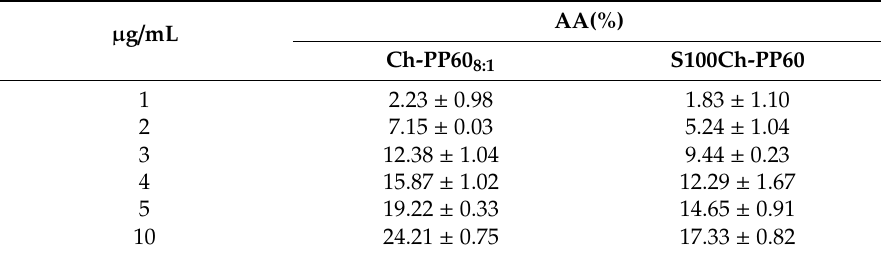
Table 3. Percentage of scavenging of free radical DPPH (antioxidant activity; AA (%) ) by Ch-PP60 8:1 and S100Ch-PP60. Values are mean ± SD ( n =